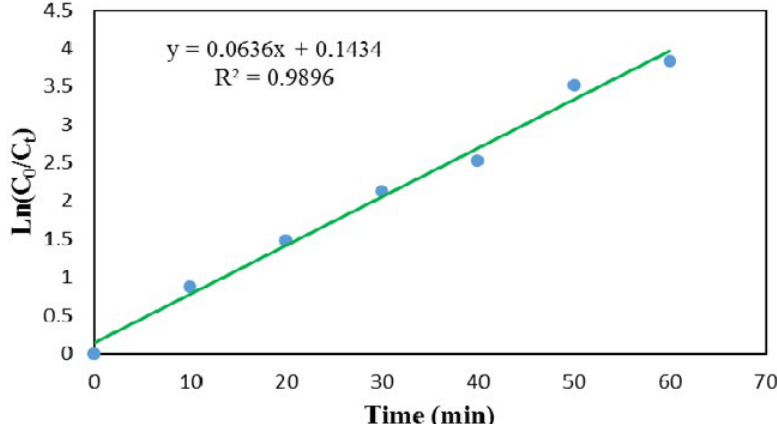
/C ) and time (t). 0 t